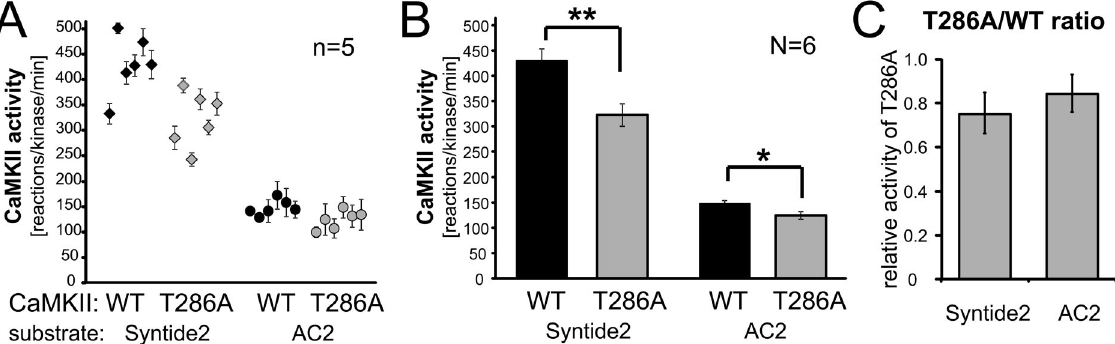
Figure 1. Maximal stimulated activity of CaMKII wild type and its T286A mutant was induced by 1 m M Ca 2 + /CaM and measured by the phosphorylation rate of two different substrates (syntide 2 and AC2) in biochemical assays. Error bars indicate mean 6 s.e.m; **: p , 0.01, *: p , 0.05 in two-tailed t-test. A , CaMKII activity in the different extracts for each kinase form (n=5 individual assays). B , The average activity of CaMKII from the individual extracts shown separately in panel A (N=6 different extracts). C , The relative activity of the T286A mutant (compared to wild type activity normalized as 1 for each substrate) based on the results shown in panel B.